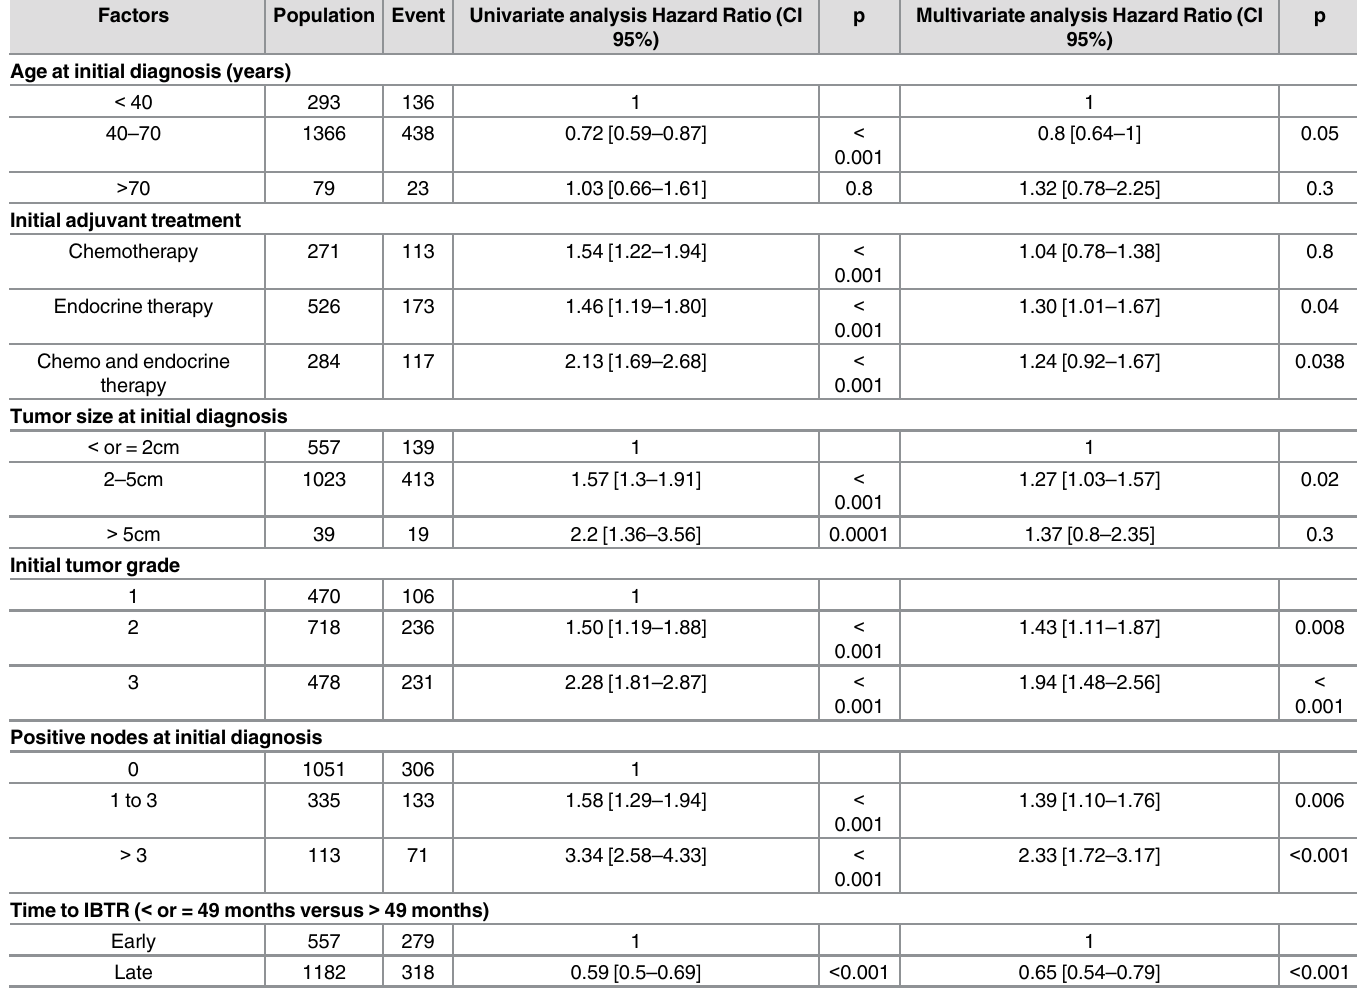
Table 2. Prognostic factors for post relapse disease free survival – hormone receptor positive